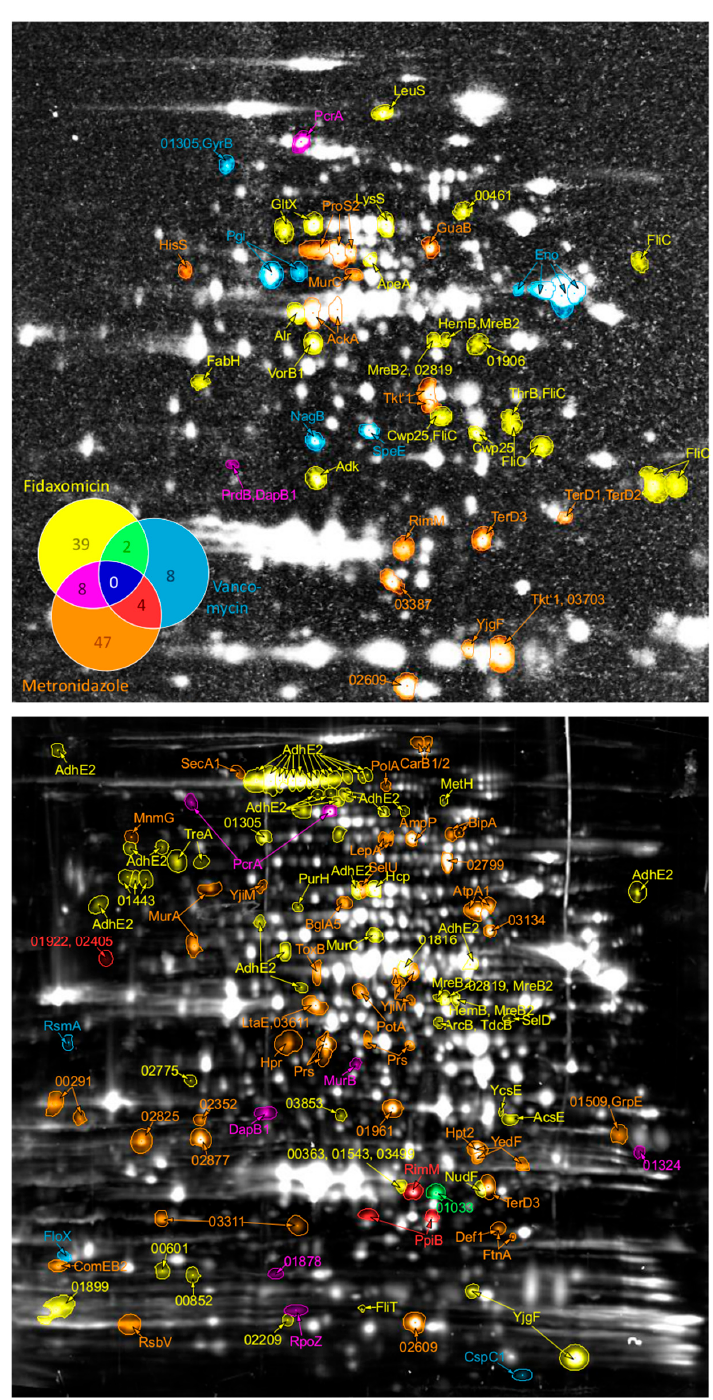
Figure 2. Protein pattern of antibiotic signatures in C. difficile . Spots of significantly changed proteins are indicated on the autoradiogram (upper part) for proteins with altered protein synthesis rate or on the 2D gel stained for total protein amount (lower part) for proteins with significantly altered amounts. Protein names (if available) or accession numbers (excluding “CDIF630erm_”) according to Dannheim et. al. [31] were used as labels. The colors as assigned in the Venn-diagram (top-left) indicate after which antibiotic treatment the proteomic response became detectable. Numbers in the Venn-diagram represent the quantity of proteins altered in synthesis rate or abundance after antibiotic treatment.